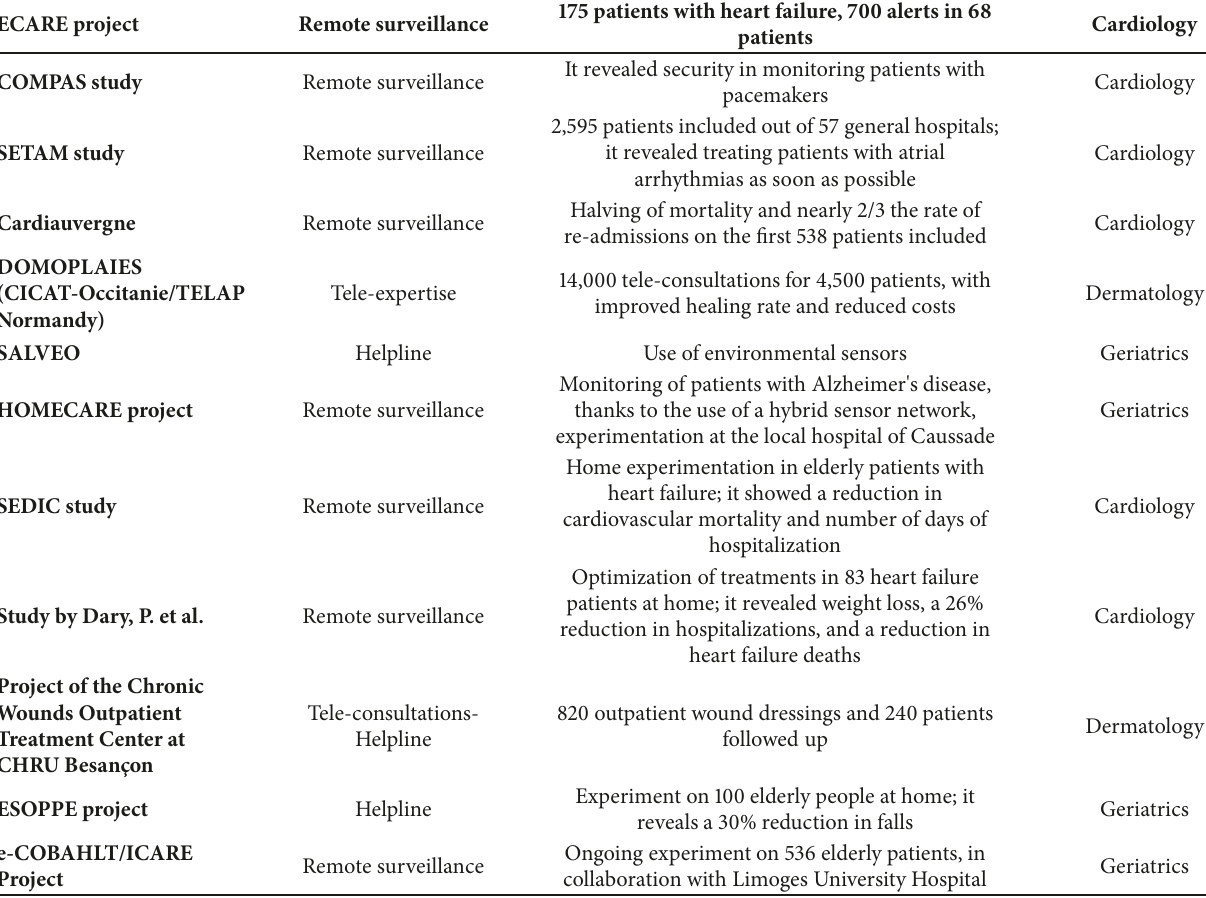
Table 2: Outpatient telemedicine